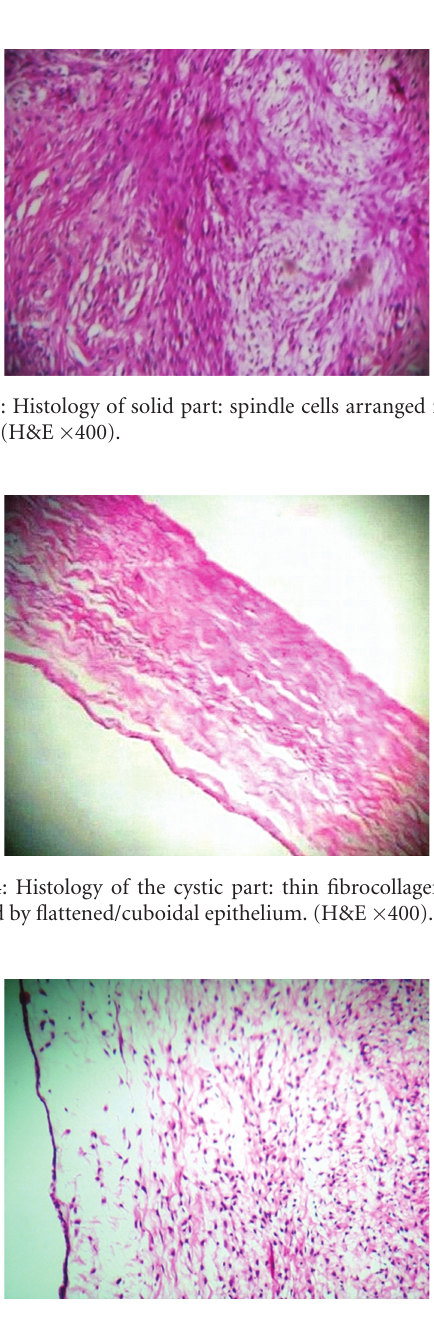
Figure 5: Histology of the interface between the solid and cystic region-shows lining by flattened epithelium. (H&E ×